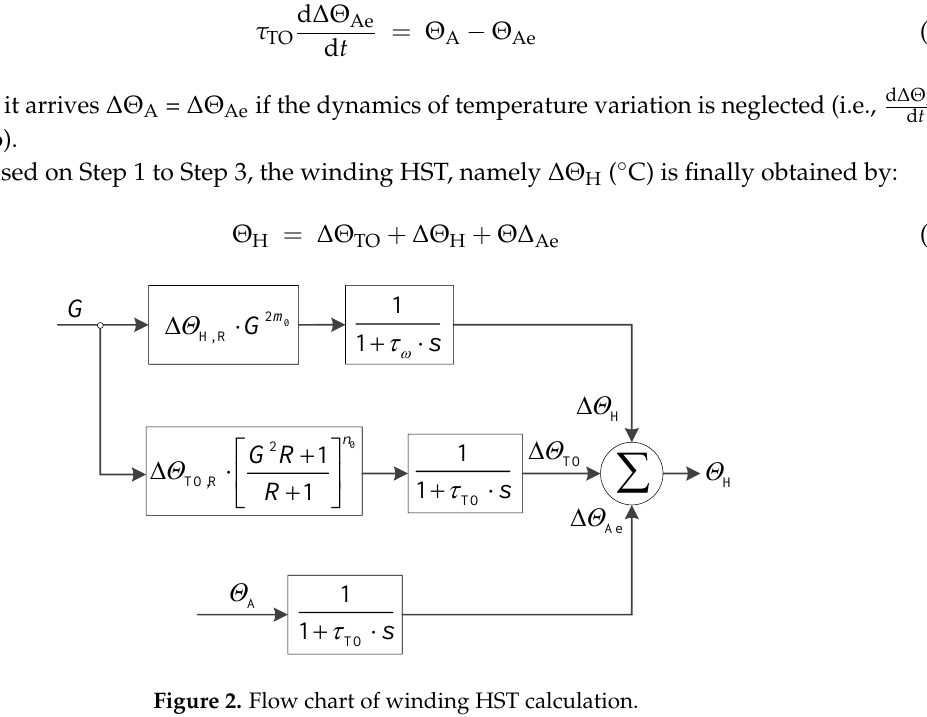
Figure 2. Flow chart of winding HST calculation.